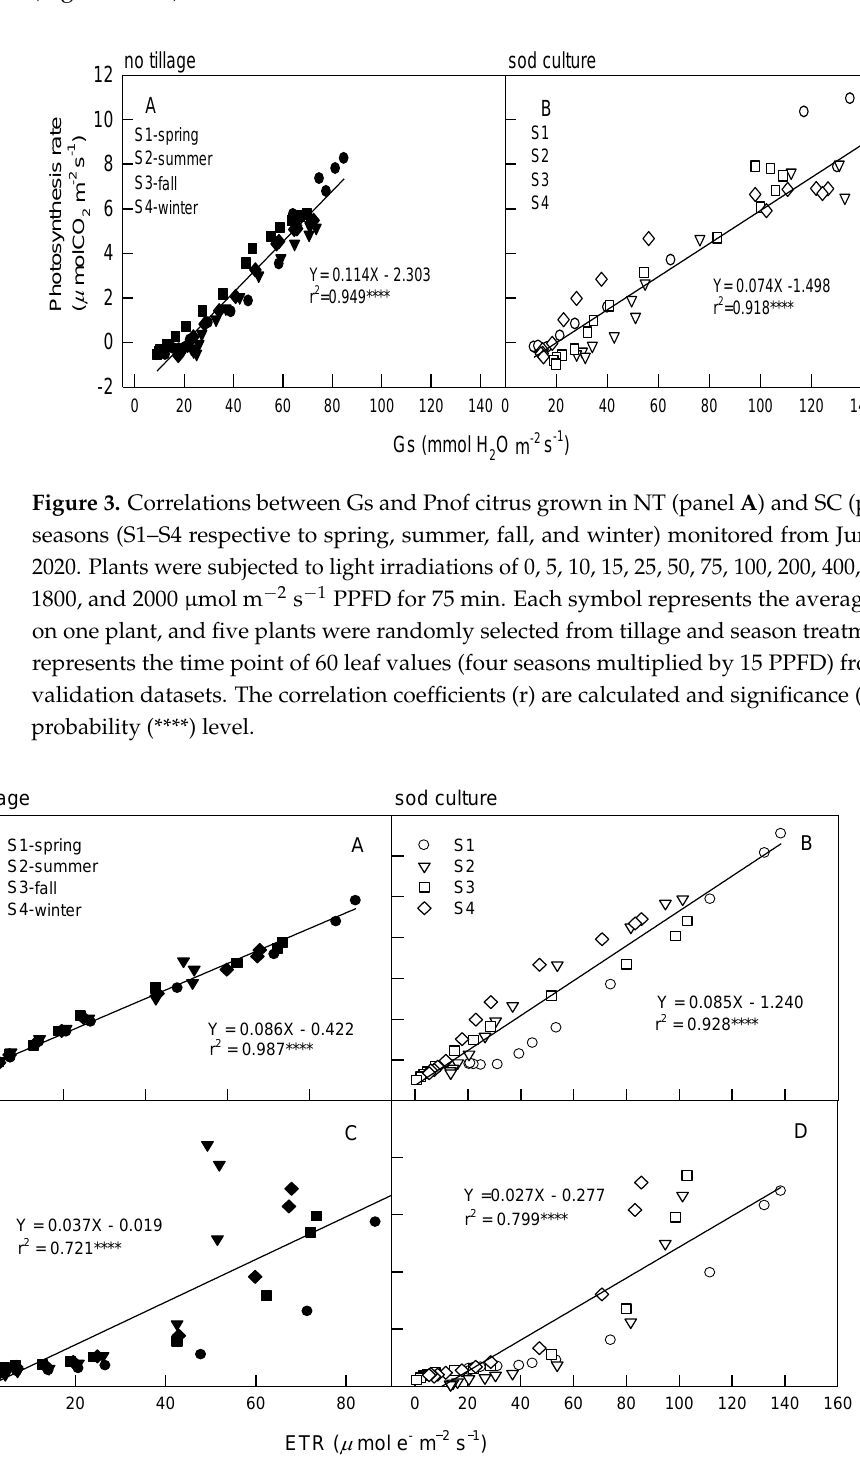
0.799 ( p < 0.0001) under NT and SC, respectively, at the same PPFD conditions and seasons (Figure 4C,D).